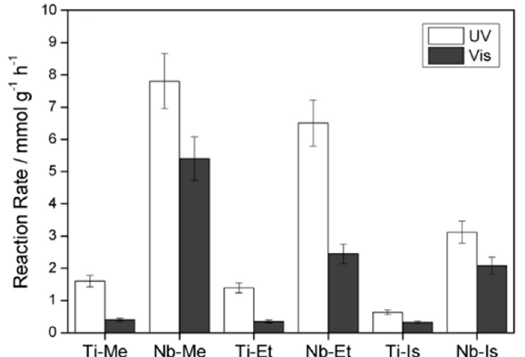
Figure 11. Reaction rate of the hydrogen photoproduction using different alcohols. Me, Et, and Is stand for methanol, ethanol, and 2-propanol (isopropanol), respectively. Reproduced with permission from the authors of [68]. Copyright (2019), Elsevier, Amsterdam, Netherlands.